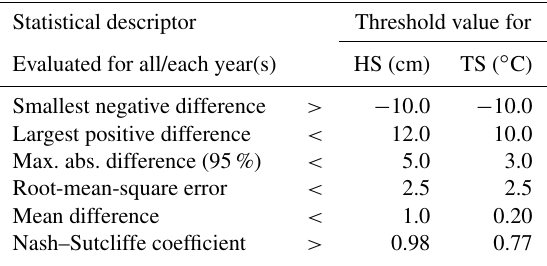
Table A1. Thresholds for snow height (HS) and snow temperature (TS) which were used to score the different SNOWPACK